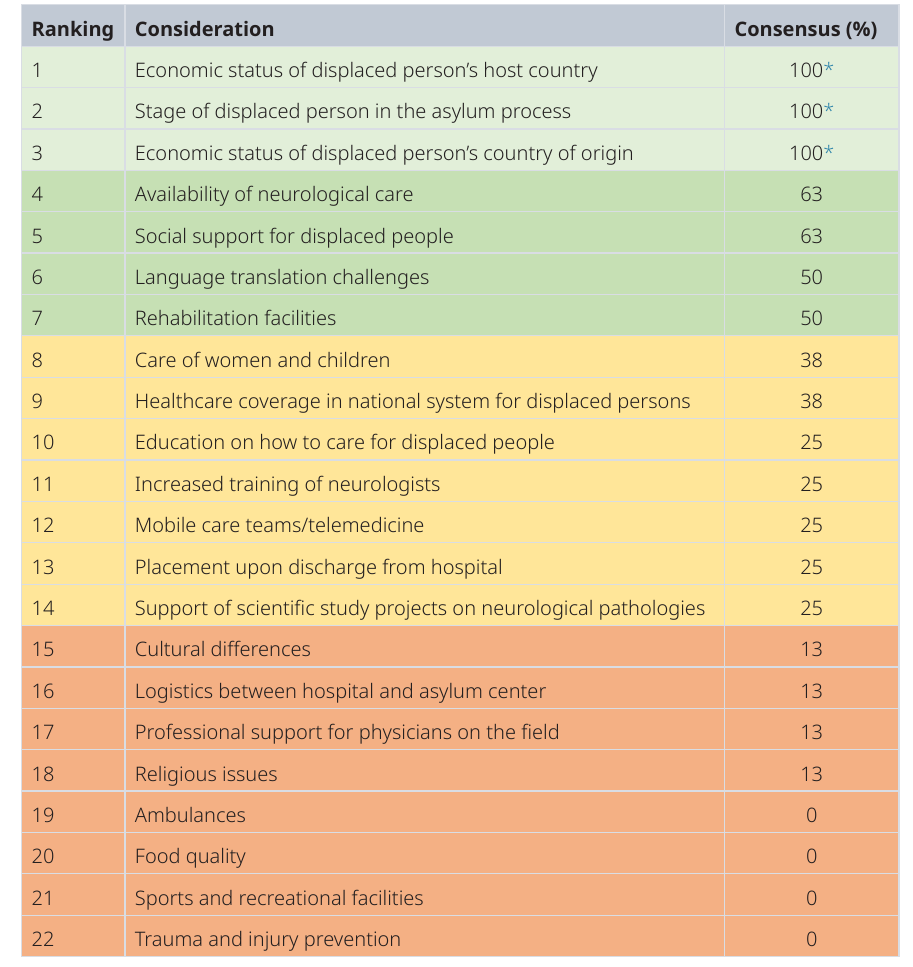
Table 1. Ranking of other important considerations when treating neurological needs of displaced